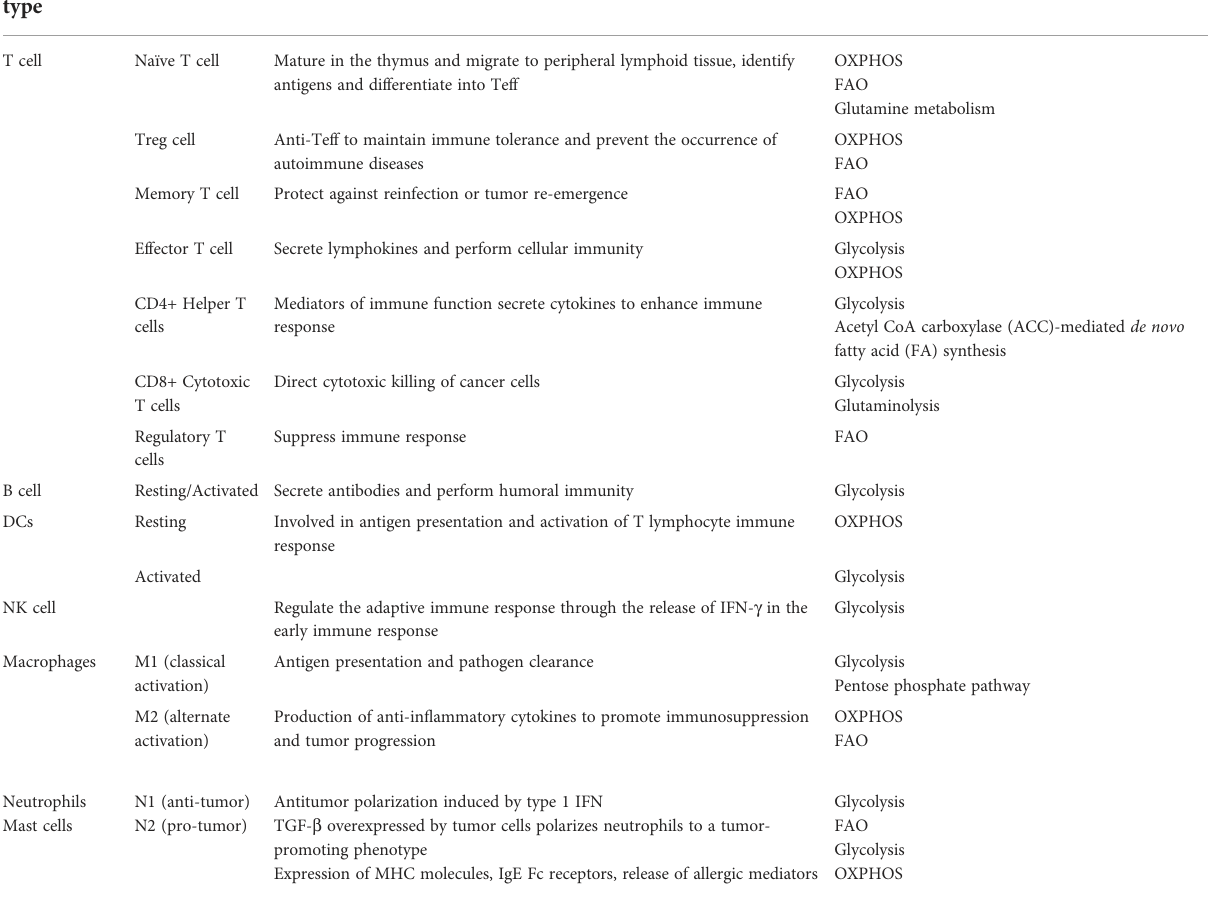
TABLE 2 Functions and metabolic phenotypes of immune